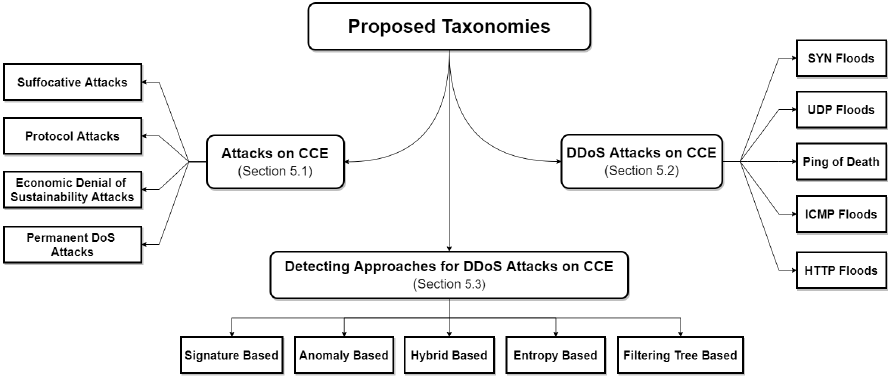
Figure 1. Proposed taxonomy of attacks, DDoS attacks, and DDoS attack detection approaches on CC.